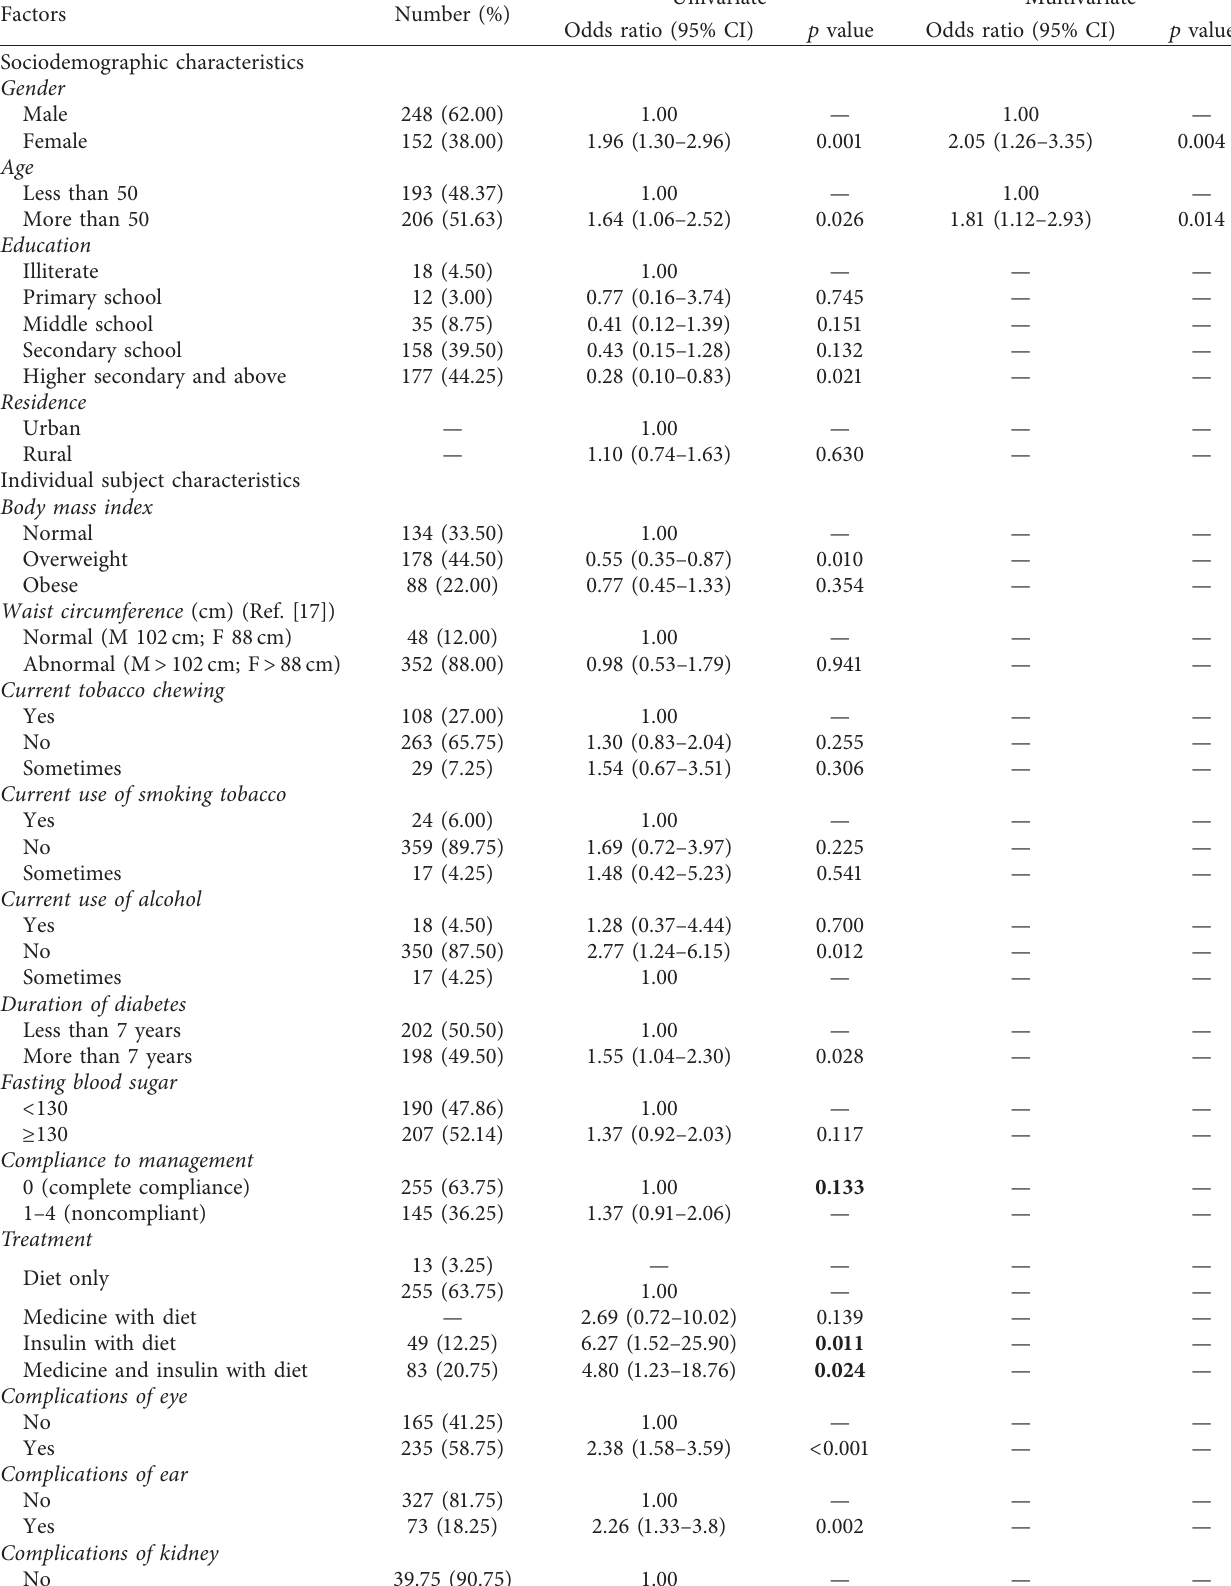
Table 2: Associating factors affecting QOLID scores in the sample and multivariate analysis determining the final predictors. Factors